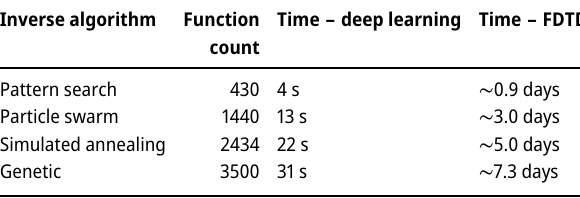
Table 3: Time required for inverse modelling. The third and fourth columns list the computational time when the forward model is being deep learning and FDTD-based models,